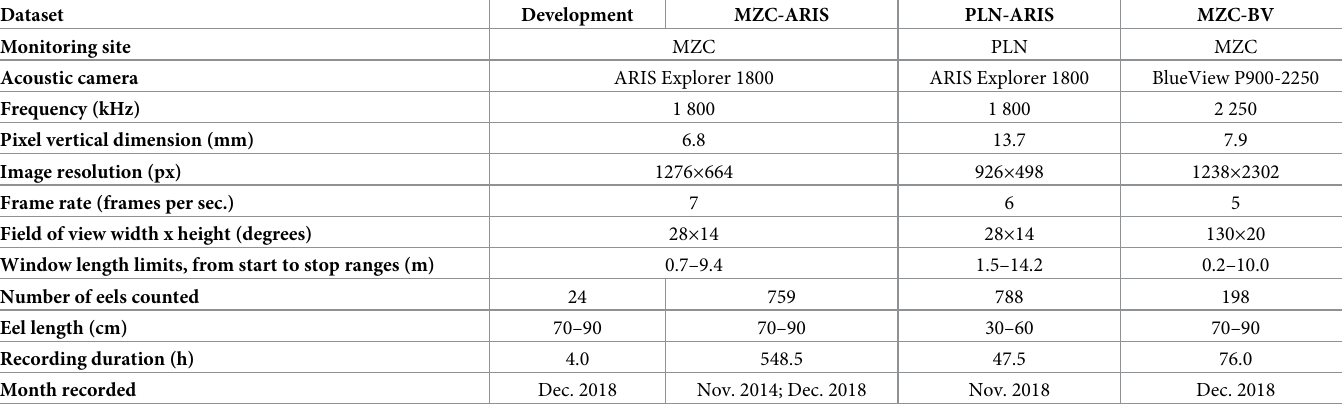
Table 1. Description of the datasets characteristics: Camera model, recording parameters and composition of the datasets, recorded at the two monitoring sites, Mauzac (MZC) and Port-La-Nouvelle (PLN).